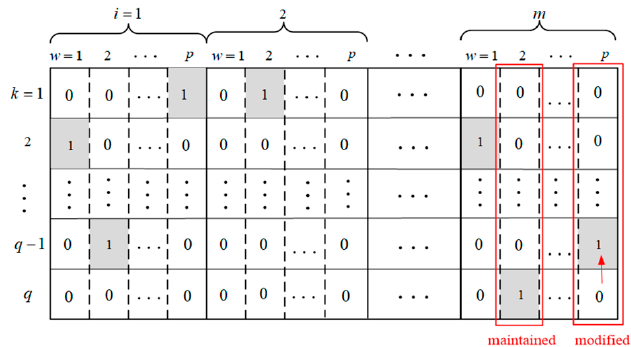
Figure 7. 2D binary coding satisfying the constraint condition.